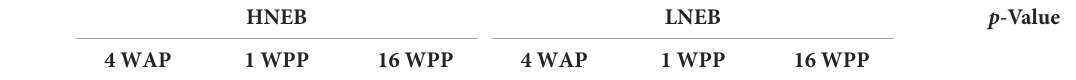
TABLE 5 Plasma FNDC3A, FNDC3B, FNDC4 and FNDC5 concentrations in HNEB and LNEB animals at 4 WAP and 1 and 16 WPP. FNDC